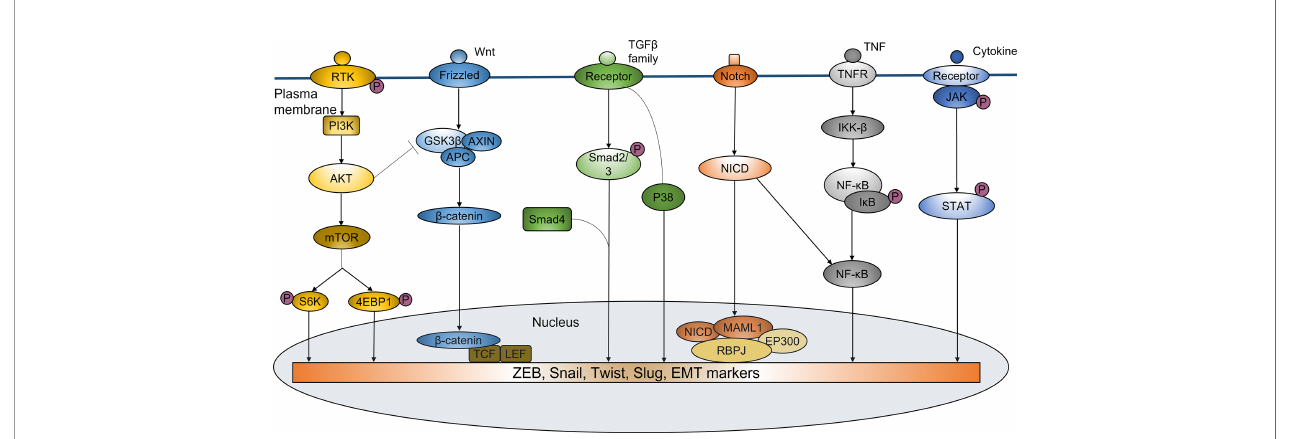
FIGURE 1 | EMT-related signaling pathways in mediating radioresistance. EMT regulated by a variety of signaling pathways plays an important role in inducing ridioresistance of tumor cells. PI3K/Akt pathway participates in the regulation of Snail and Twist. PI3K/Akt activation can also increase phosphorylation, ubiquitination and degradation of GSK-3 b , thus decreasing its degradation to Snail. Wnt/ b -catenin signaling can promote the radioresistance by increasing nuclear translocation of b -catenin and transcriptional upregulation of EMT-related genes expression. TGF- b signaling can regulate the expression of EMT markers to induce EMT by Smad or non-Smad-dependent ways, thus enhancing the resistance of cancer cells to irradiation. Notch signaling can increase the expression of ZEB1, Slug, Snail, NF- k B and Vimentin to promote the EMT phenotype. NF- k B pathway has the important roles in EMT-mediated radioresistance. It is involved in the regulation of EMT genes such as Twist, Slug and SIP1. IL-6/JAK/STAT6 pathway can induce EMT by mediating ZEB1 and EMT-related markers, resulting in enhanced tumor resistance to